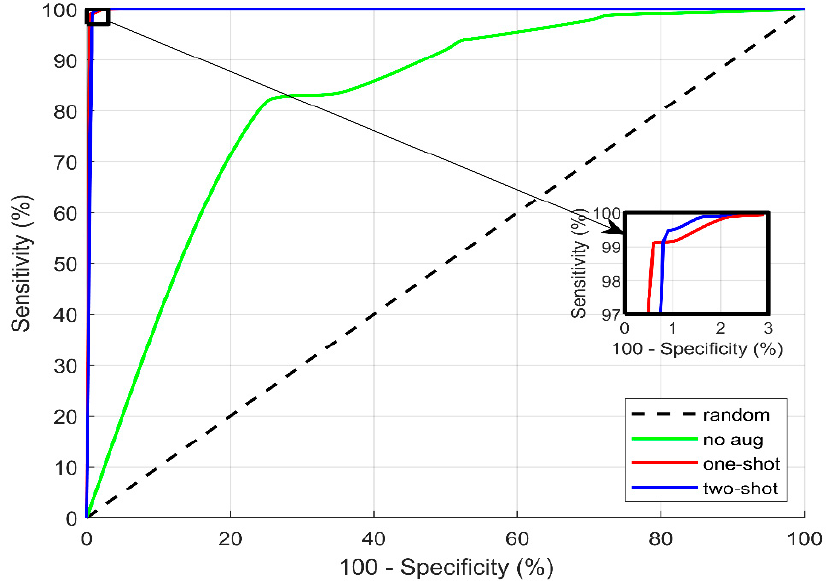
Figure 9. Data visualization using mapping into two dimensions using t-distributed stochastic neighbor embedding (t-SNE).